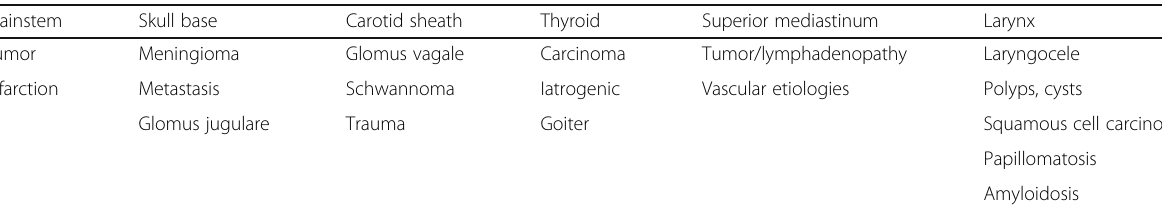
Table 1 Differential diagnosis of vocal cord dysfunction by location